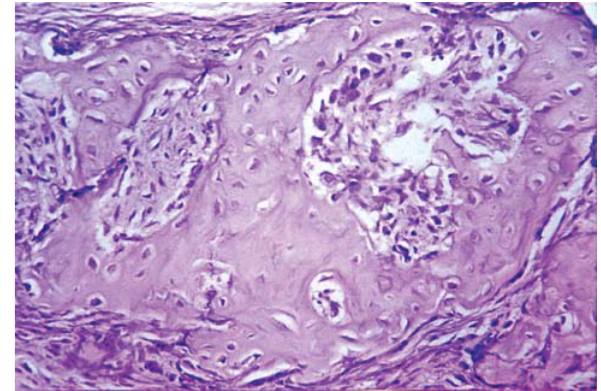
FIGURE 6- 15 days BB group. High concentration of collagen fibers (H.E., original magnification, x200)